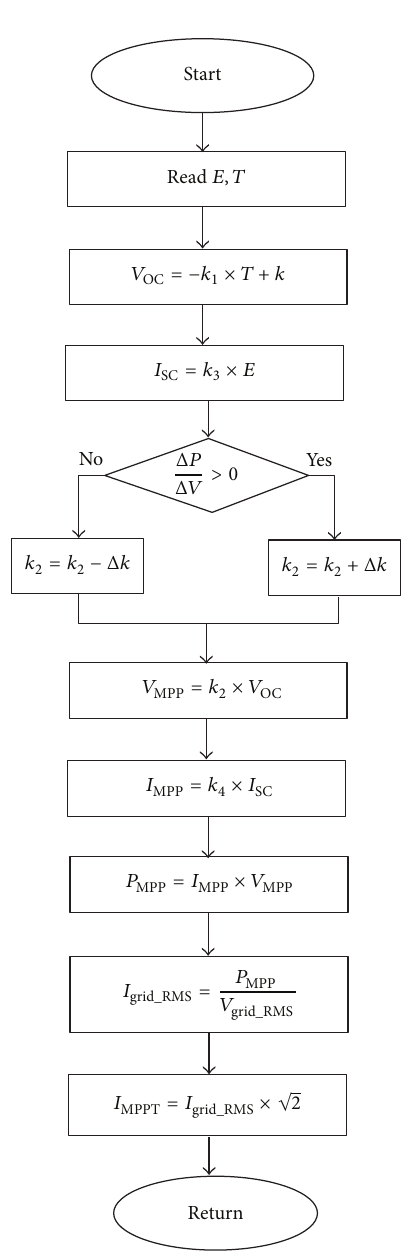
Figure 9: Flowchart of the proposed MPPT